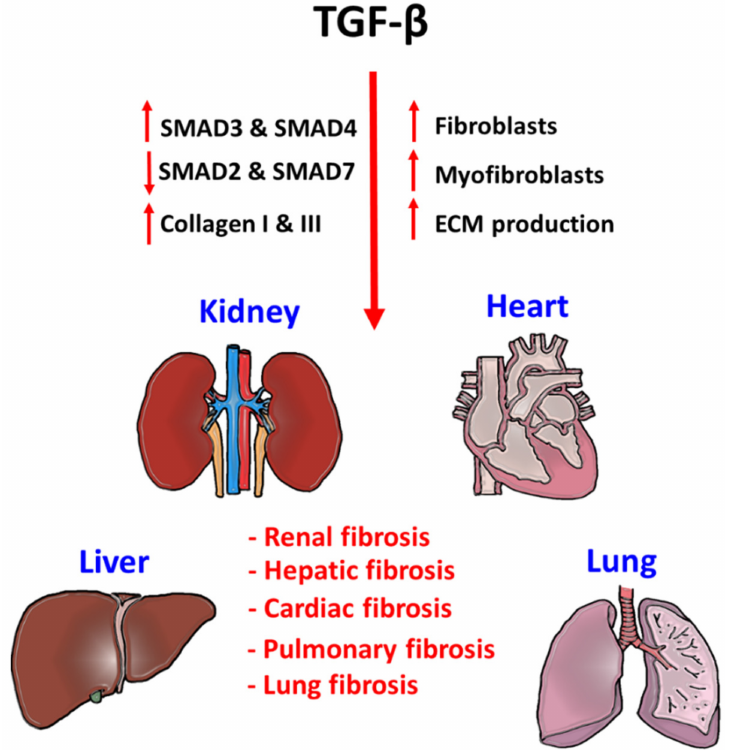
Figure 3. Pathogenic role of TGF- β signaling in tissue fibrosis. TGF- β signaling is a critical factor for initiating fibrogenesis in kidney, liver, heart, and lung. Phosphorylation of pro-fibrotic SMAD3 and SMAD4, and repression of